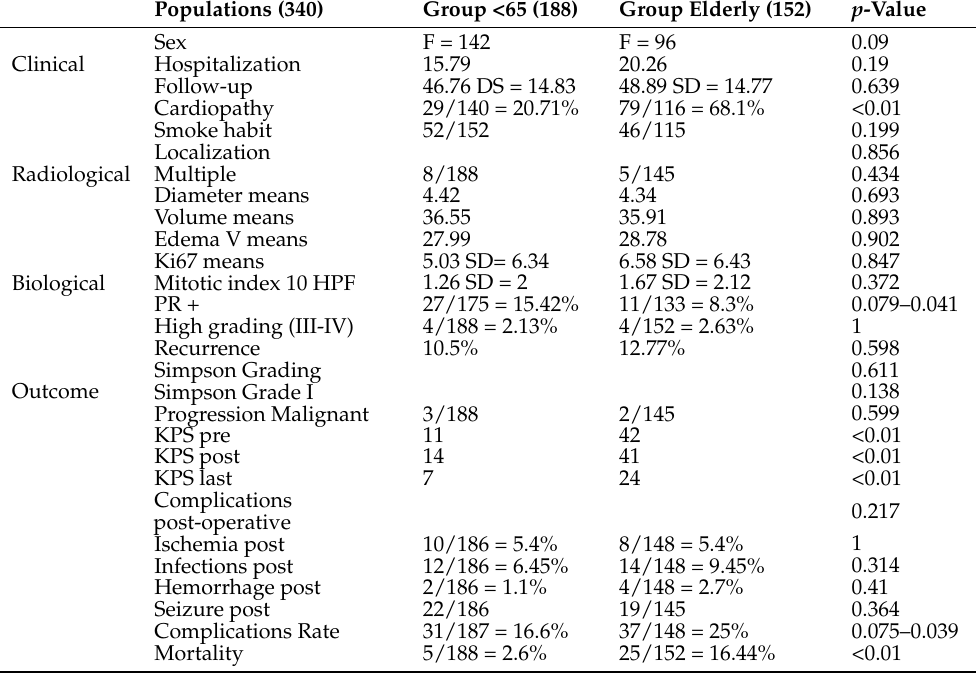
Table 1. Patients populations with clinical, radiological, biological, and outcome analyses